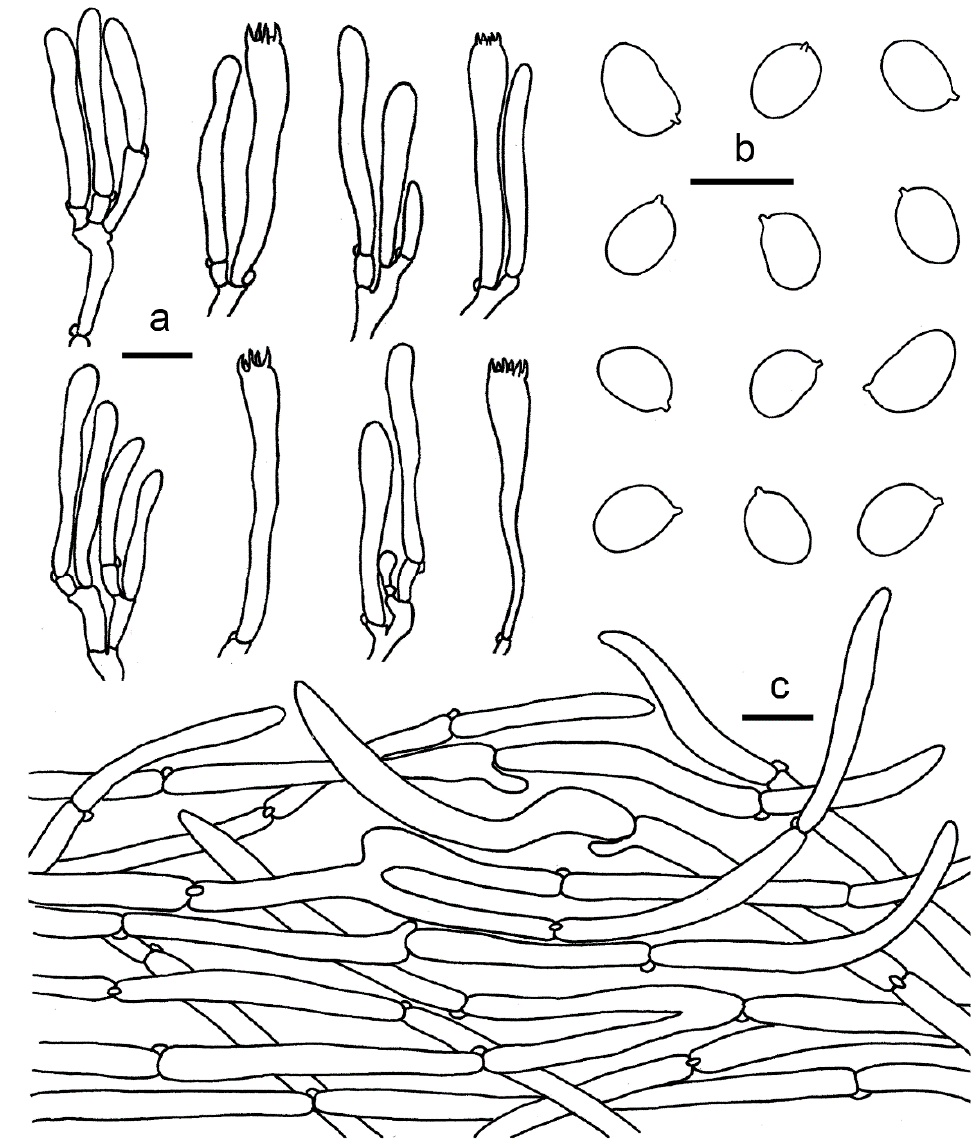
Figure 5. Cantharellus aurantinus (GDGM46278, Holotype!). ( a ) Basidia, basidiola and elements of the subhymenium. ( b ) Basidiospores. ( c ) Pileipellis. Bars: ( a , b ) = 10 µ m; ( c ) = 20 µ m.